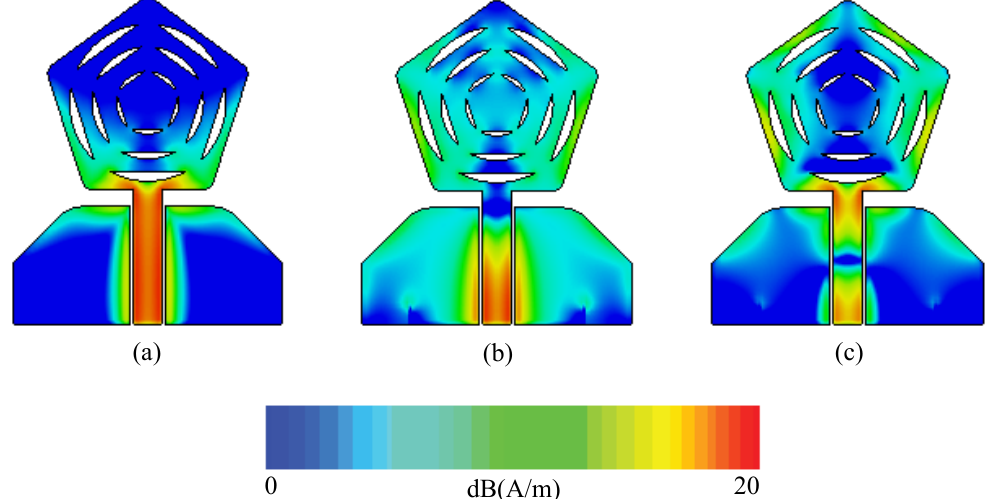
Figure 5. Simulated surface current distribution of the proposed CPW-fed pentagonal fractal antenna at ( a ) 4 GHz, ( b ) 8 GHz, and ( c ) 12